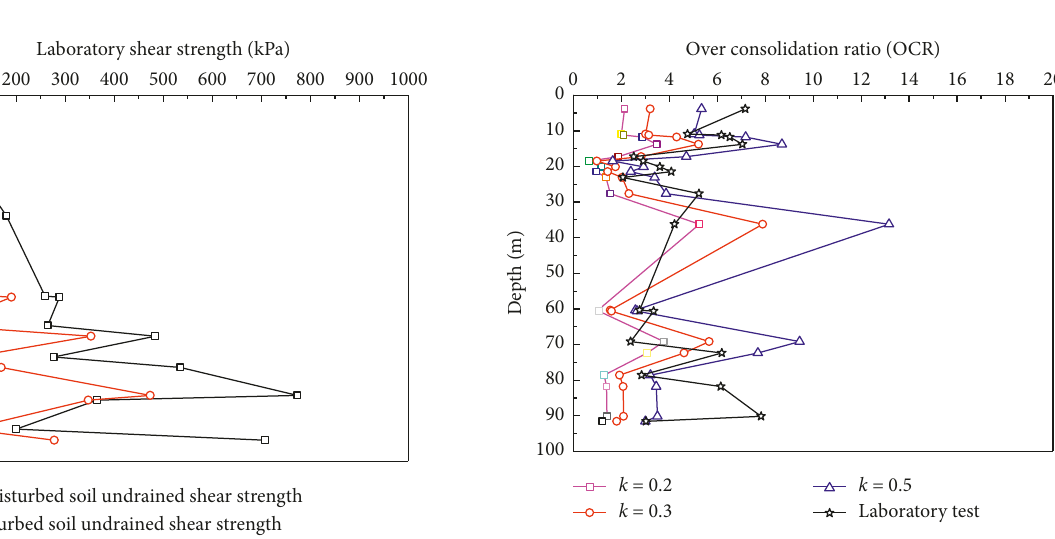
Figure 12: Comparison of the OCR results from laboratory tests and CPT tests with different k